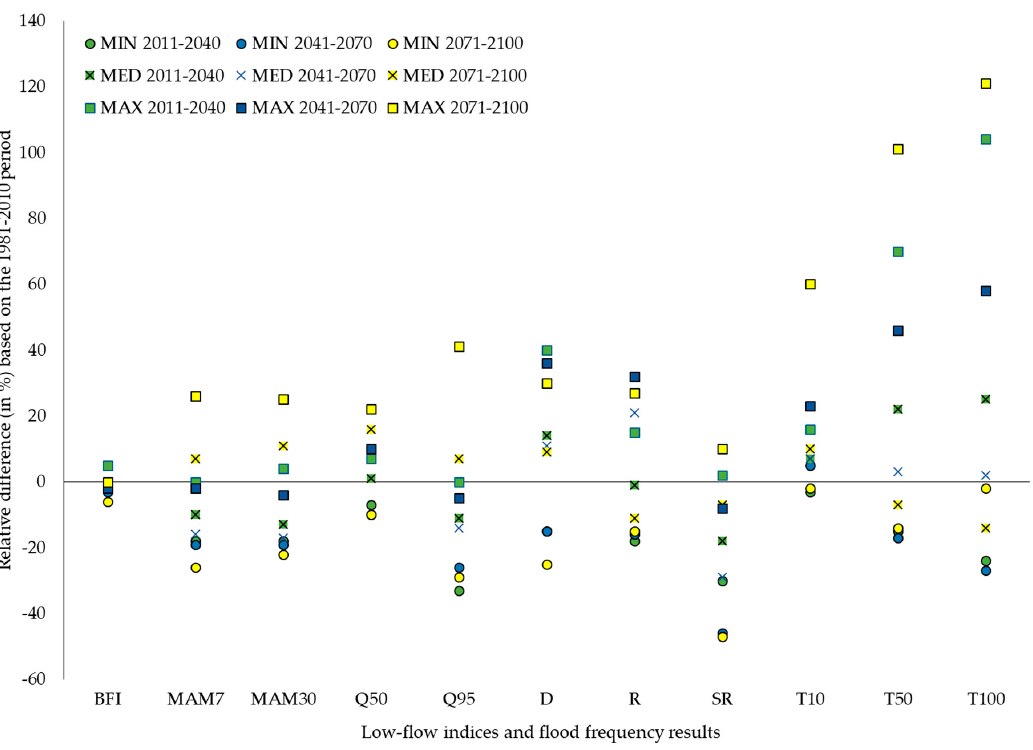
Figure 5. Low-flow indices and flood frequency results (T10, T50, T100 are discharge with 10, 50, and 100-year return period, respectively) for the periods of 2011–2040, 2041–2070, and 2071–2100 for the Vrhnika gauging station (Ljubljanica River). All values are given as a relative difference (in %) based on the 1981–2010 period. Five climate models were investigated and the minimum, median, and maximum values of these five models (RCP4.5 scenario was used) are shown. Different colors represent different 30-year periods and different symbols (i.e., circle, cross, and rectangle) represent the minimum, mean, and maximum values.